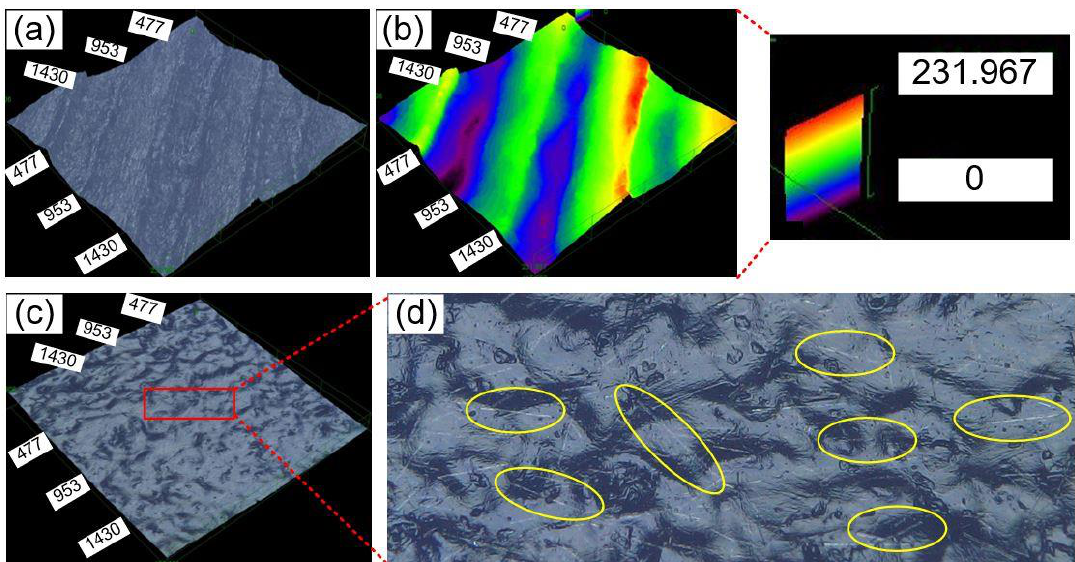
Figure 4. Surface morphology of a 6 wt.% CF-reinforced HDPE composite: ( a ) top surface, ( b ) height variation represented with different colors for the top surface, ( c ) bottom surface, and ( d ) a magnified area on the bottom surface with highlighted carbon fibers.